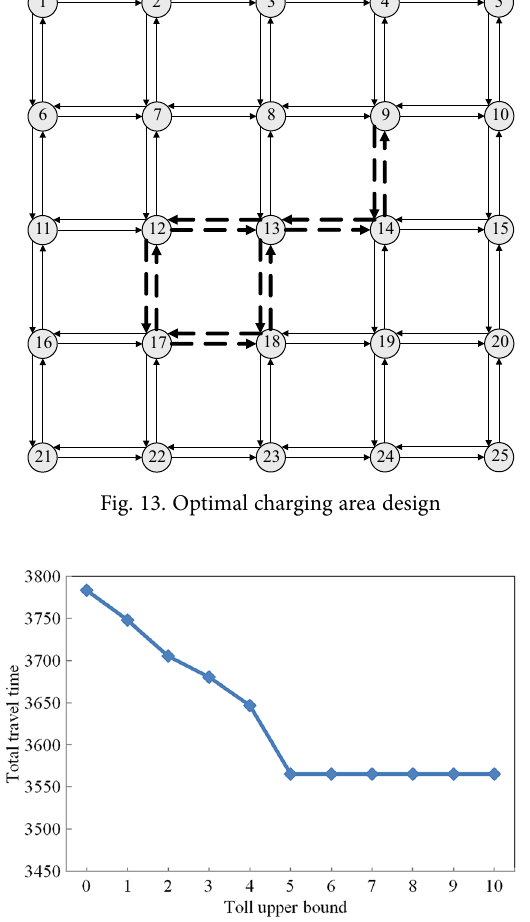
Fig. 14. Optimal objective values with different toll upper bounds under area